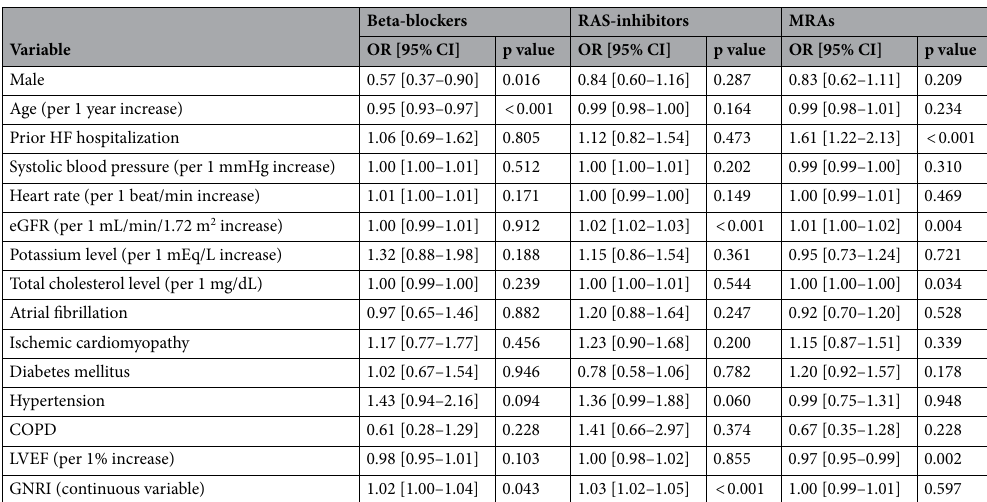
Table 2. Clinical variables contributing to optimal medial therapy administration. RAS-I renin-angiotensin system inhibitor, MRA mineralocorticoid receptor antagonist, HF heart failure, eGFR estimated glomerular